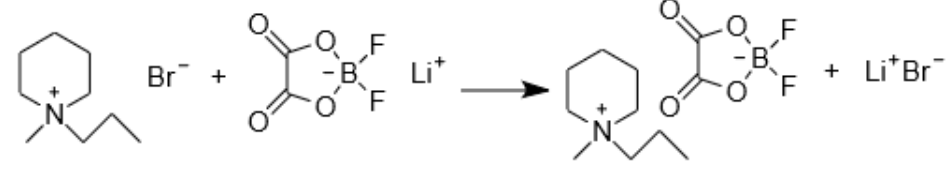
Figure 1. Scheme of the metathesis